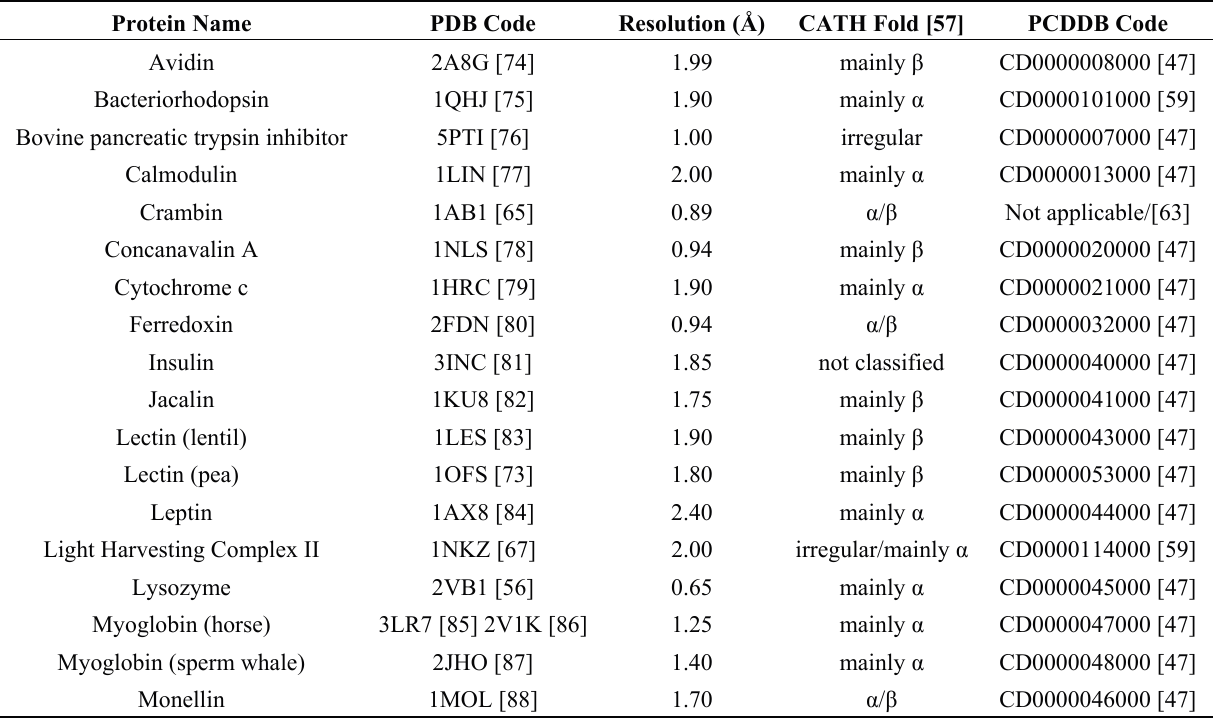
Table 6. PDB Structures and Literature CD